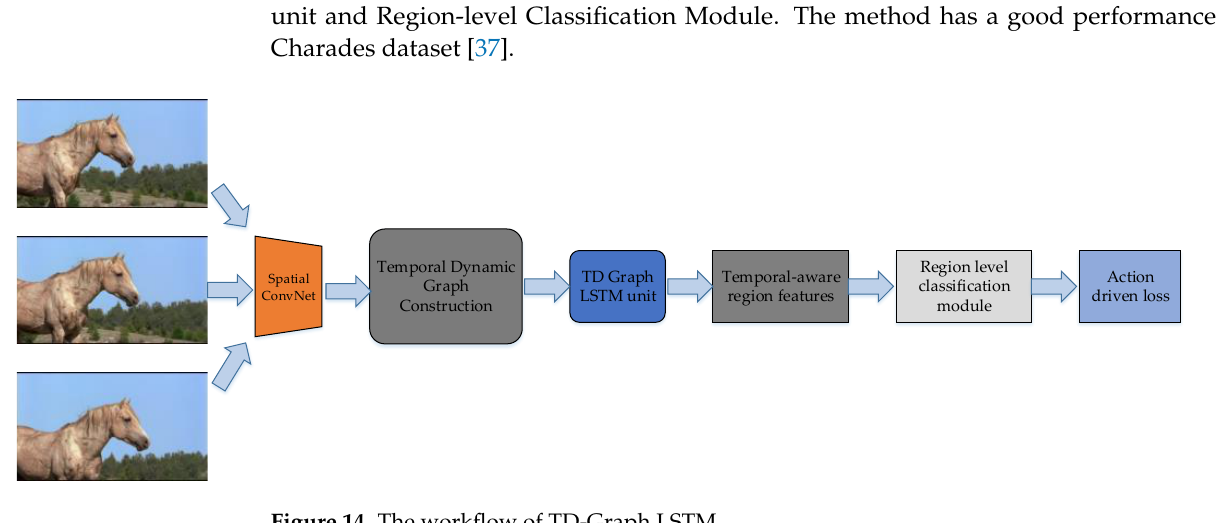
Figure 14. The workflow of TD-Graph LSTM.